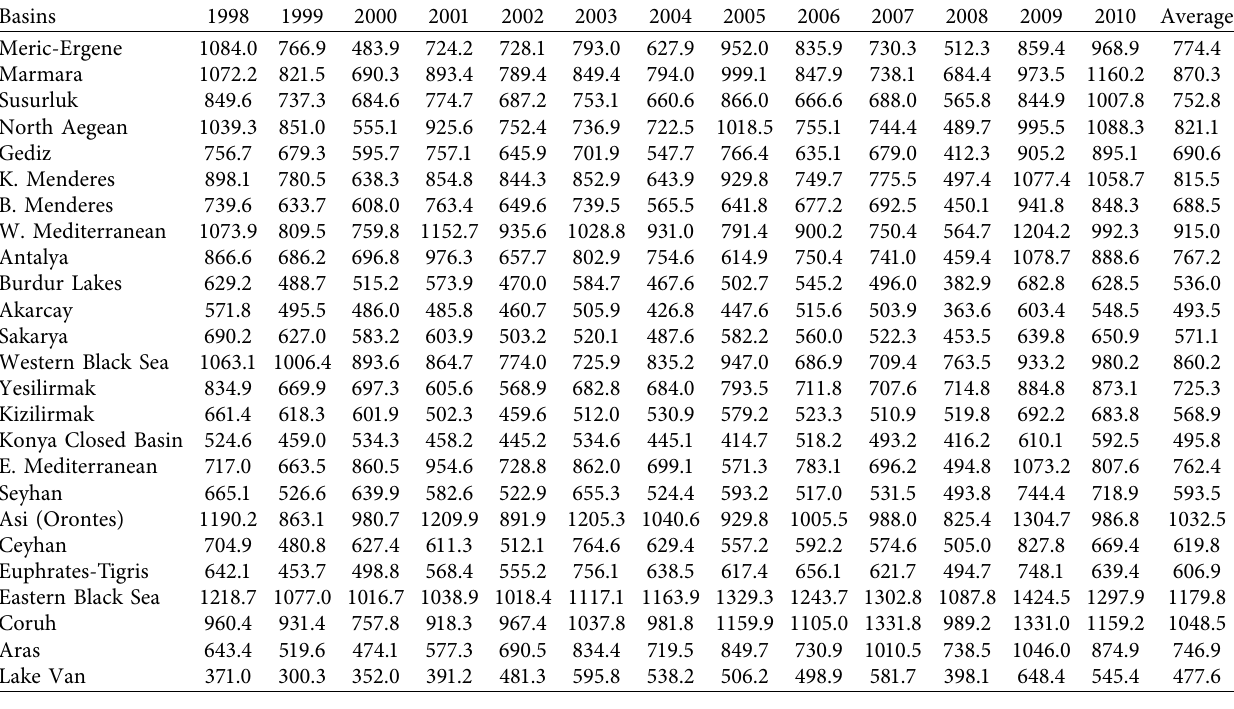
Table 5: Total annual precipitation (mm) from CFSR data for the years 1998–2010.